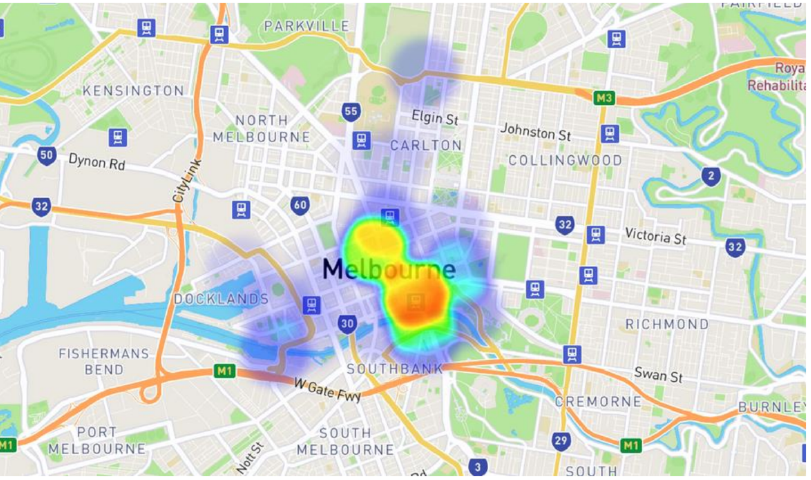
Figure 6. The heat map of a probability model of crowds in the city of Melbourne. A smoothed plot was generated by overlapping Gaussian kernels weighted with the estimated crowd